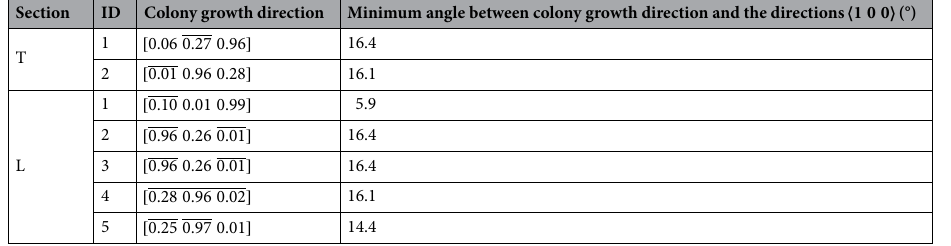
Table 1. For the regions identified in Fig. 7 by an ID, colony growth direction and minimum angle between the corresponding colony growth direction and the prior fcc directions belonging to the family (cid:31) 1 0 0 (cid:30) .